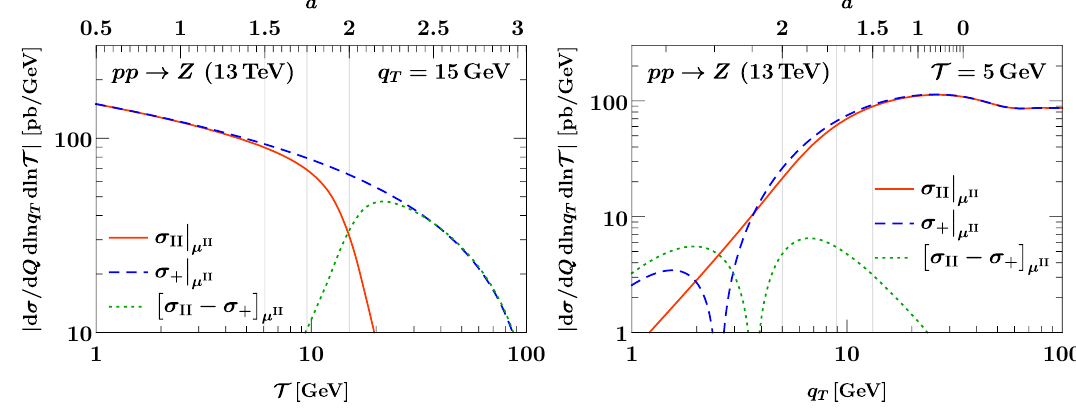
Figure 8 . Singular/nonsingular comparison between SCET II and SCET + at NNLL as a function of T for (cid:12)xed q T = 15 GeV (left) and as a function of q T for (cid:12)xed T = 5 GeV (right). The orange solid lines show the full SCET II result including resummation. The dashed blue lines show the corresponding SCET + singular limit with only SCET II resummation. The dotted green lines show their di(cid:11)erence, corresponding to the power corrections indicated in eq. (3.1). The thin vertical lines indicate our choice of transition points ( a 4 ; a 5 ; a 6 ) with respect to the regime parameter a (upper horizontal axis), as discussed in section